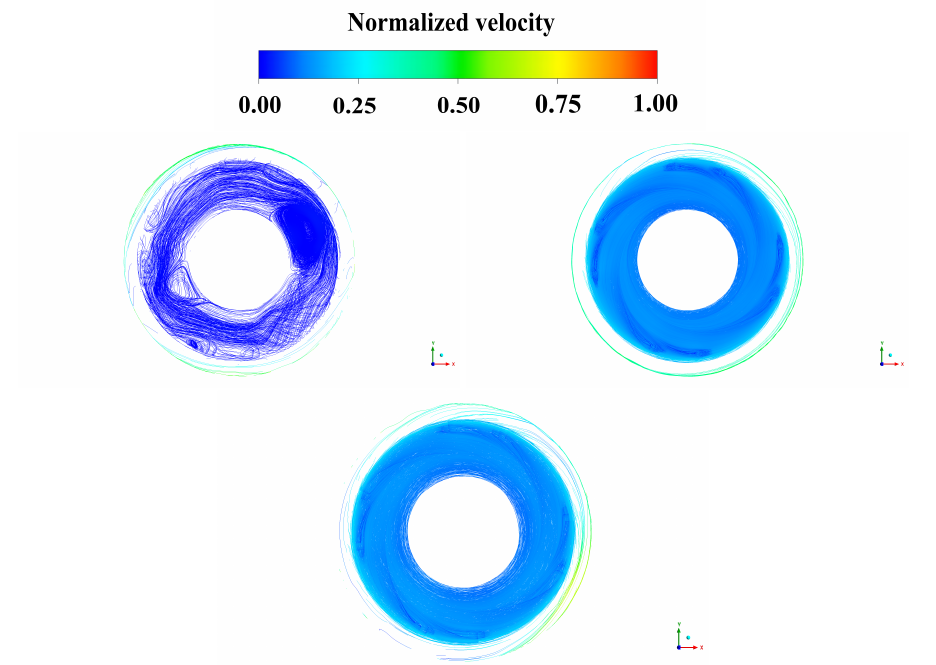
Figure 8. Velocity distributions of the crown chamber with the 0.5 mm (top-left ), 1.5 mm ( top-right ), and 2.5 mm ( lower ) radial installation deviation